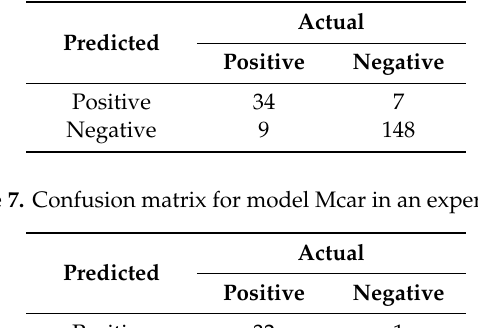
Table 6. Confusion matrix for model Fsuv in an experiment.